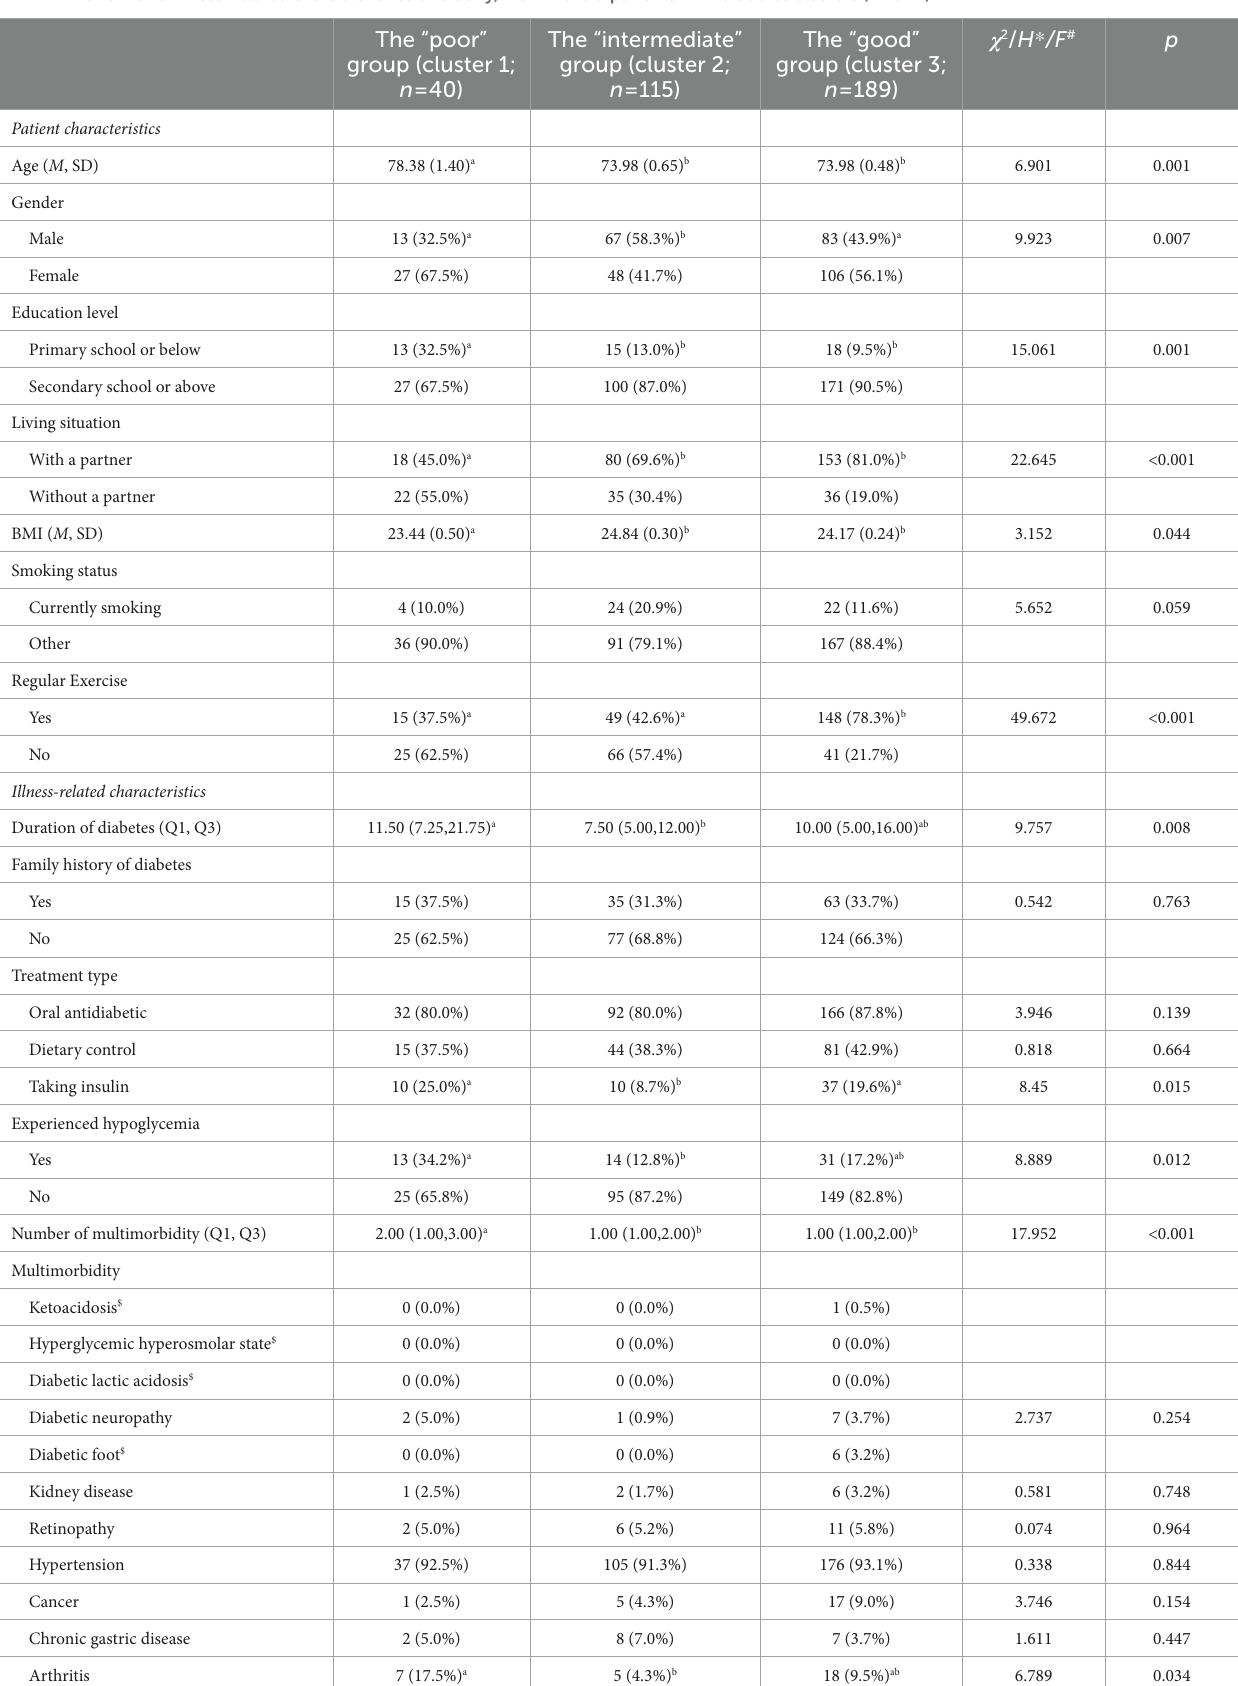
TABLE 4 Patient and illness-related characteristics of elderly, multimorbid patients with diabetes clusters ( N = 344).